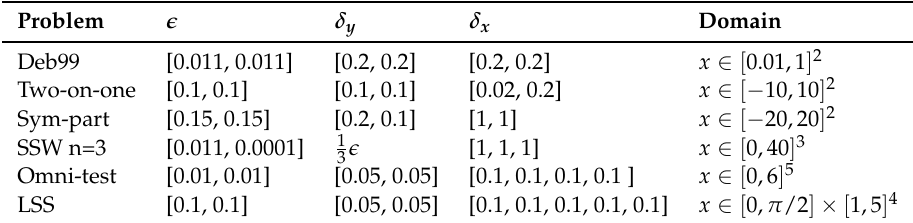
Table 1. Parameters used for the experiments.